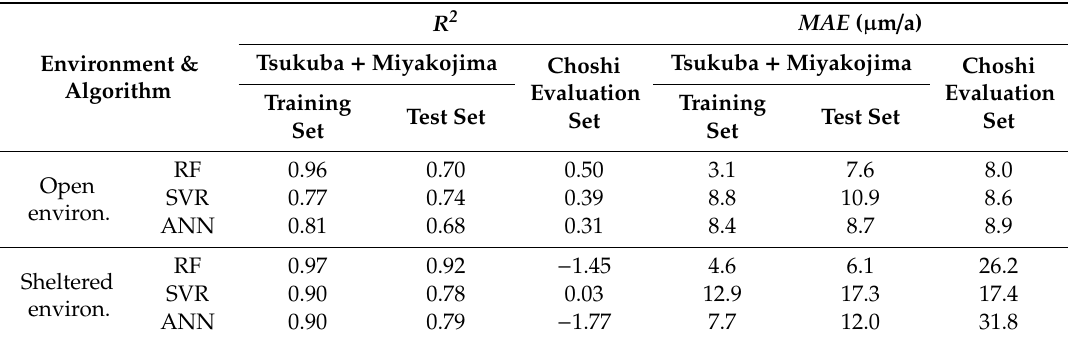
Table 4. The predictive accuracy of the random forest (RF), support vector regressor (SVR), and artificial neural network (ANN) models for steel samples under open and sheltered environments. The samples in the exposure test sites of Tsukuba and Miyakojima were used to train the models and verify their prediction accuracy. The samples in the exposure test site of Choshi were used to demonstrate the generalization ability of the